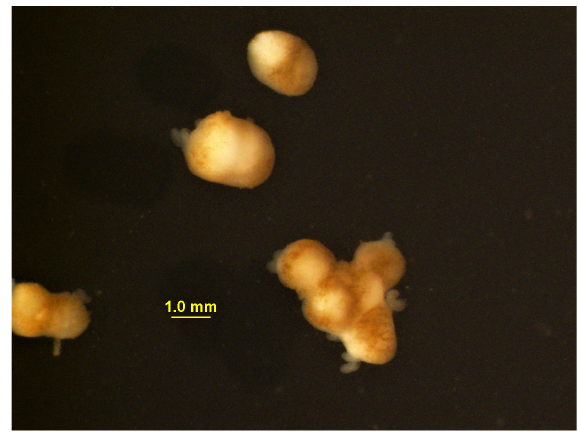
Figure 2. Single polyps and clusters of polyps with zooxanthellae and extended filaments. Micrograph of single polyps and clusters of polyps placed in a glass petri dish, taken using an Olympus SZX16 stereomicroscope with a computer-linked 2.0x objective lens. Total magnification is 17.0x. Small brown dots in the polyp tissue are endosymbiotic zooxanthellae. Coiled filaments are thought to be mesenteries which may aid in resettlement, through adhesion, or